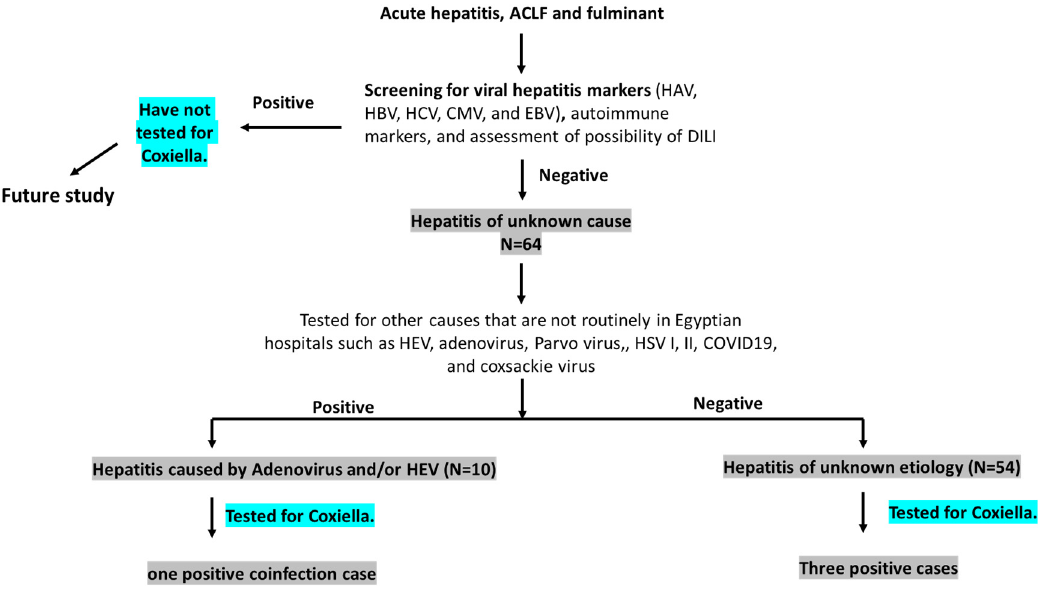
Figure 1. Definition of cases and study design. Sixty ‐ four cases of HUC that tested negative for common viral hepatitis, autoimmune hepatitis markers, and were not drug ‐ induced liver injury (DILI) were screened for less common pathogens. Fifty ‐ four cases were negative for the less common pathogens and labeled as acute hepatitis of unknown etiology (AHUE). Three samples tested positive for Q fever from AHUE. Ten out of 64 samples tested positive for less common pathogens such as HEV and adenovirus, of which one case was diagnosed as HEV/Q ‐ fever coinfection.